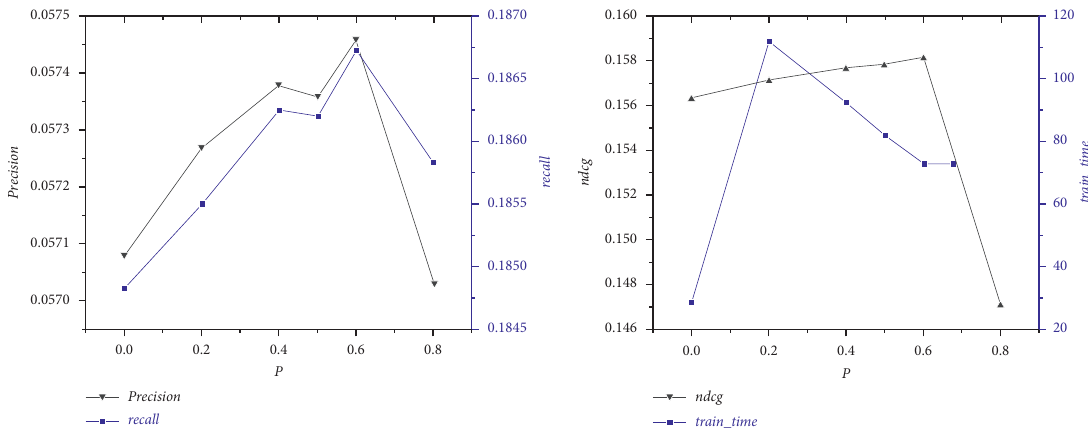
Figure 5: Algorithm performance under different edge drop rates (Gowalla).